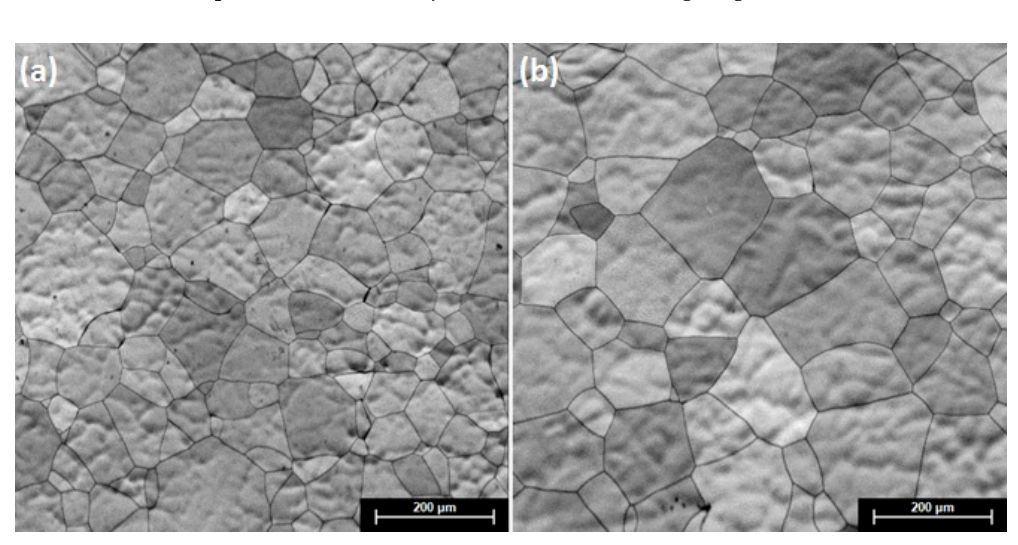
Figure 4. The SEM images of the Ti-Nb-Zr-Fe-O alloy microstructures in: ( a ) the as-cast state; ( b ) after the homogenisation treatment—named the initial state.